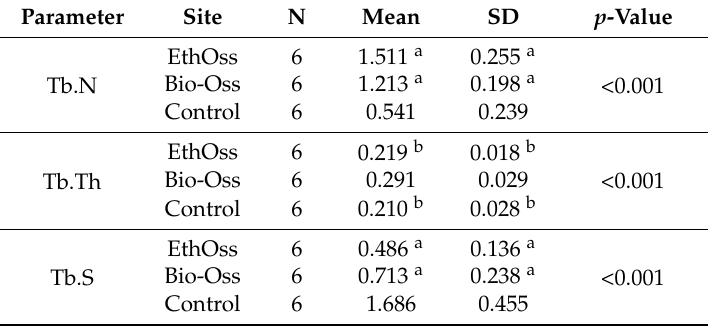
Table 3. Comparison of parameters associated with the microarchitecture of the newly-formed hard tissue in the three groups (a: p < 0.05 vs. control; b: p < 0.05 vs. Bio-Oss).